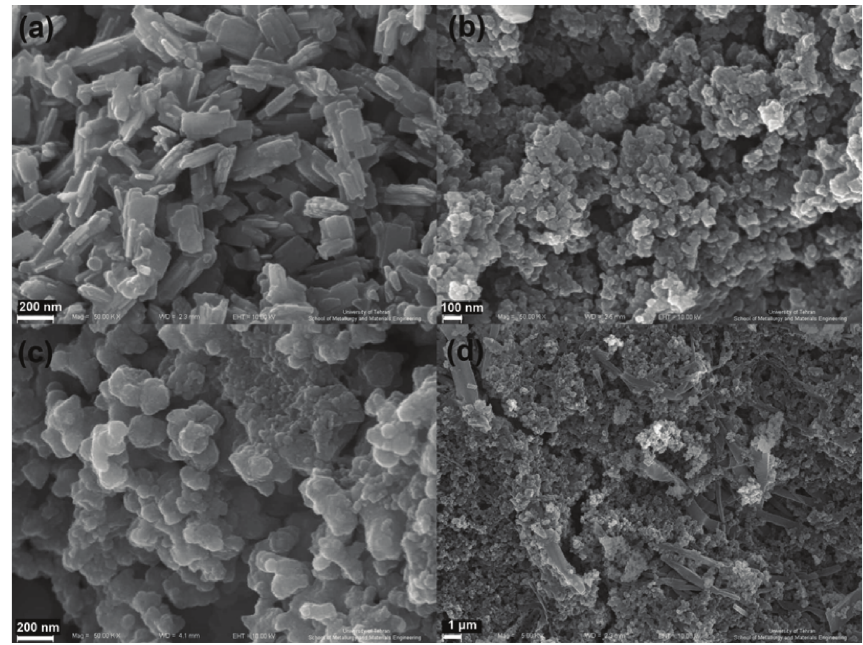
Figure 4: SEM of posnjakite nanopar- ticles in 600 W: (a) 10, (b) 15, (c) 20 and (d) 25 min.